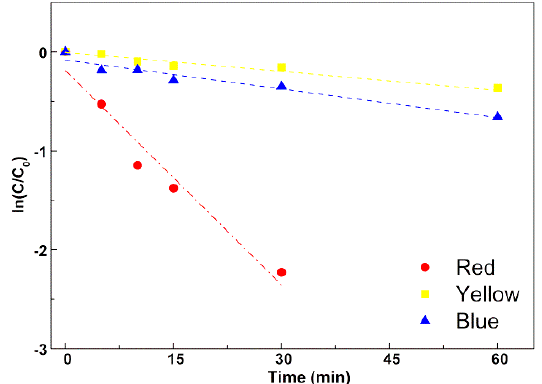
Figure 11. Plot of the pseudo-first-order kinetics for degradation of textile dyes. Red: C.I. Reactive Red 195; Blue: C.I. Reactive Blue 250; Yellow: C.I. Reactive Yellow 145.